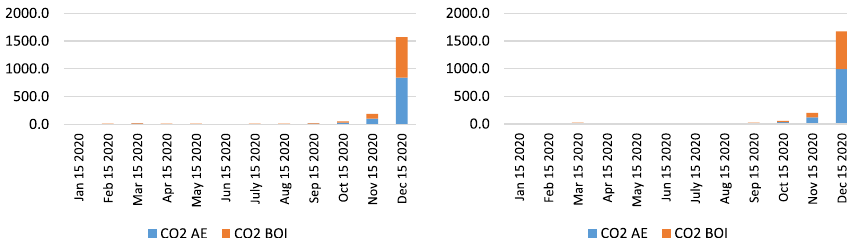
Fig. 15 CO2 emission calculation of ships at anchorage area of the ports LA&LB based on energy and fuel‑based methodology (left) and Starcrest (right) in 2020 (in the average waiting time by months)